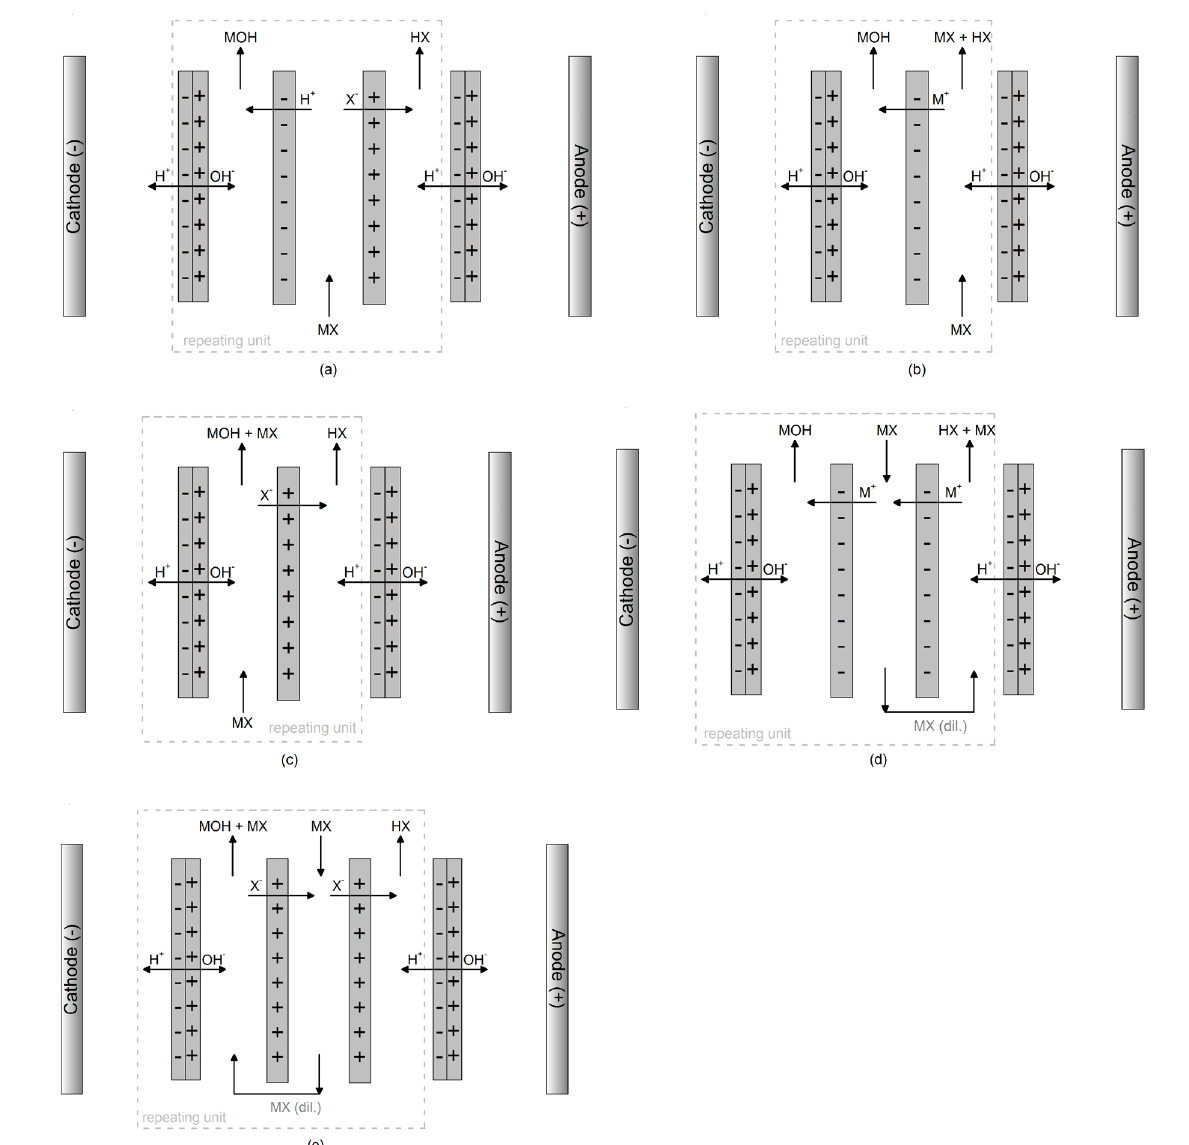
Figure 3: Schematic representation of bipolar membrane electrodialysis in a three-compartment (a), two-compartment (b, c) and high conversion (d, e)